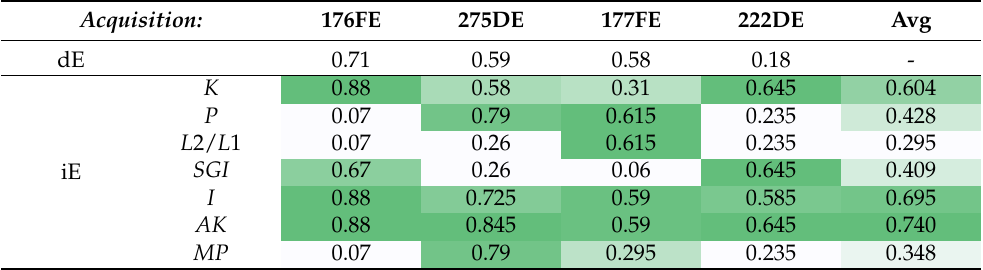
Table 3. Summary of the results in terms of demodulation and indicator